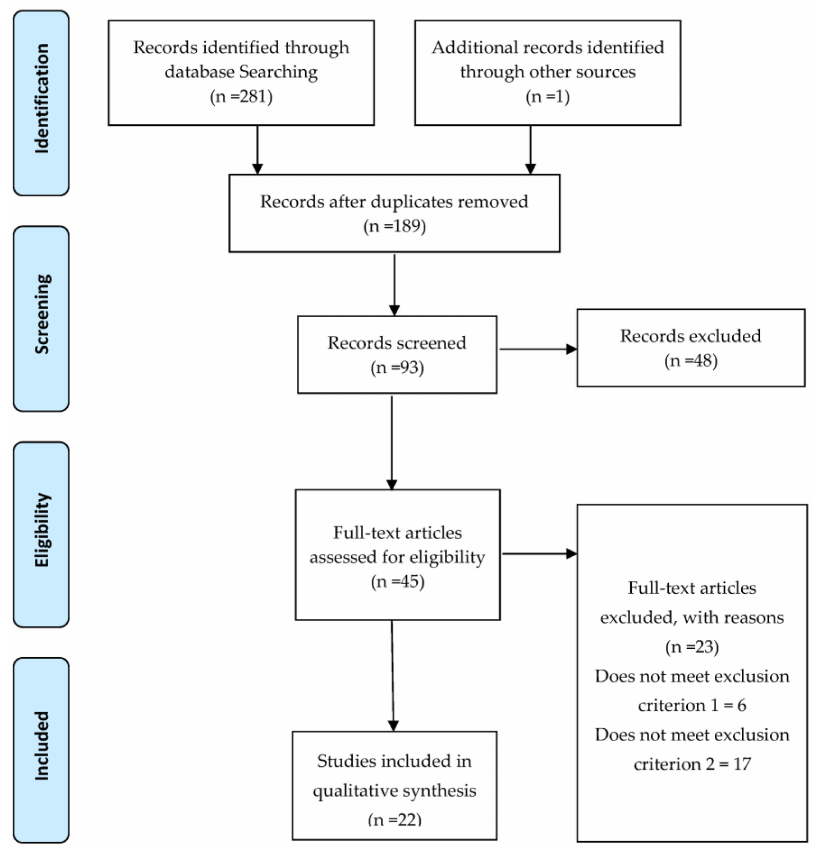
Figure 1. PRISMA flow